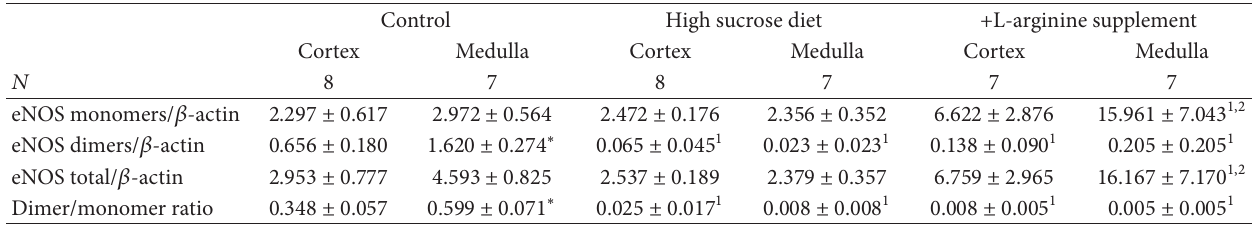
Table 1: Effect of high sucrose diet and L-Arginine supplementation on eNOS/ 𝛽 -actin ratio in kidney cortex and medulla.